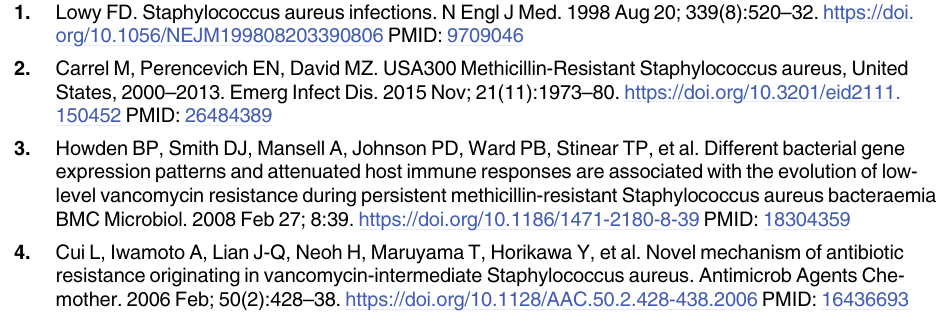
S3 Table. A summary of mutation effects on MIC, mprF activation, cytochrome c binding and 2 hr. survival assay with LL-37. This table shows the summary of MICs of PMB, mprF expression, cytochrome c binding and 2 hr. LL-37 susceptibility assays. Expression of mprF is relative comparison. For cytochrome c binding, the parent JE2 is set at 100%. For LL-37 assay, survival without LL-37 is set at 100%. The symbols indicate the following: "" / " / # / ## (high / moderate / low / considerably low